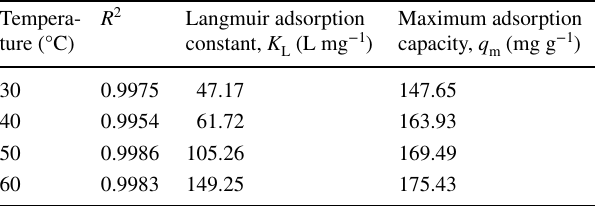
Table 3 Langmuir isotherm parameters for adsorption of methylene blue on coconut coir dust with varying temperatures Tempera- ture (°C)